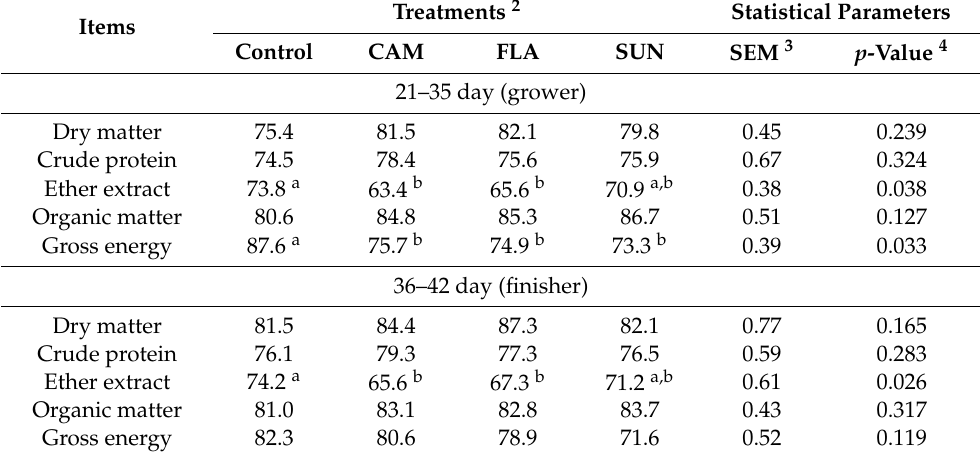
Table 4. Apparent nutrients and energy digestibility of broilers chickens fed a control, camelina, flax, and sunflower diet, % 1